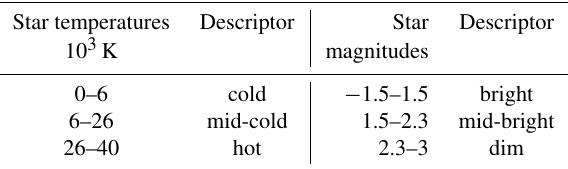
Table 2. Classes of star properties (as defined in this